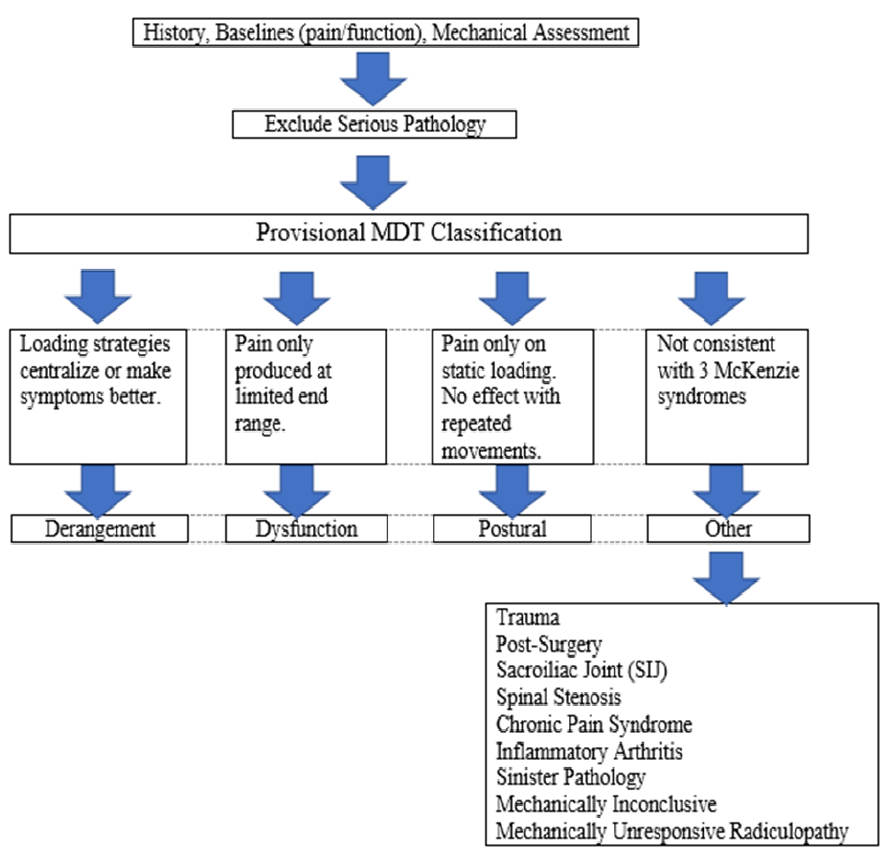
Table 1. McKenzie MDT Classification